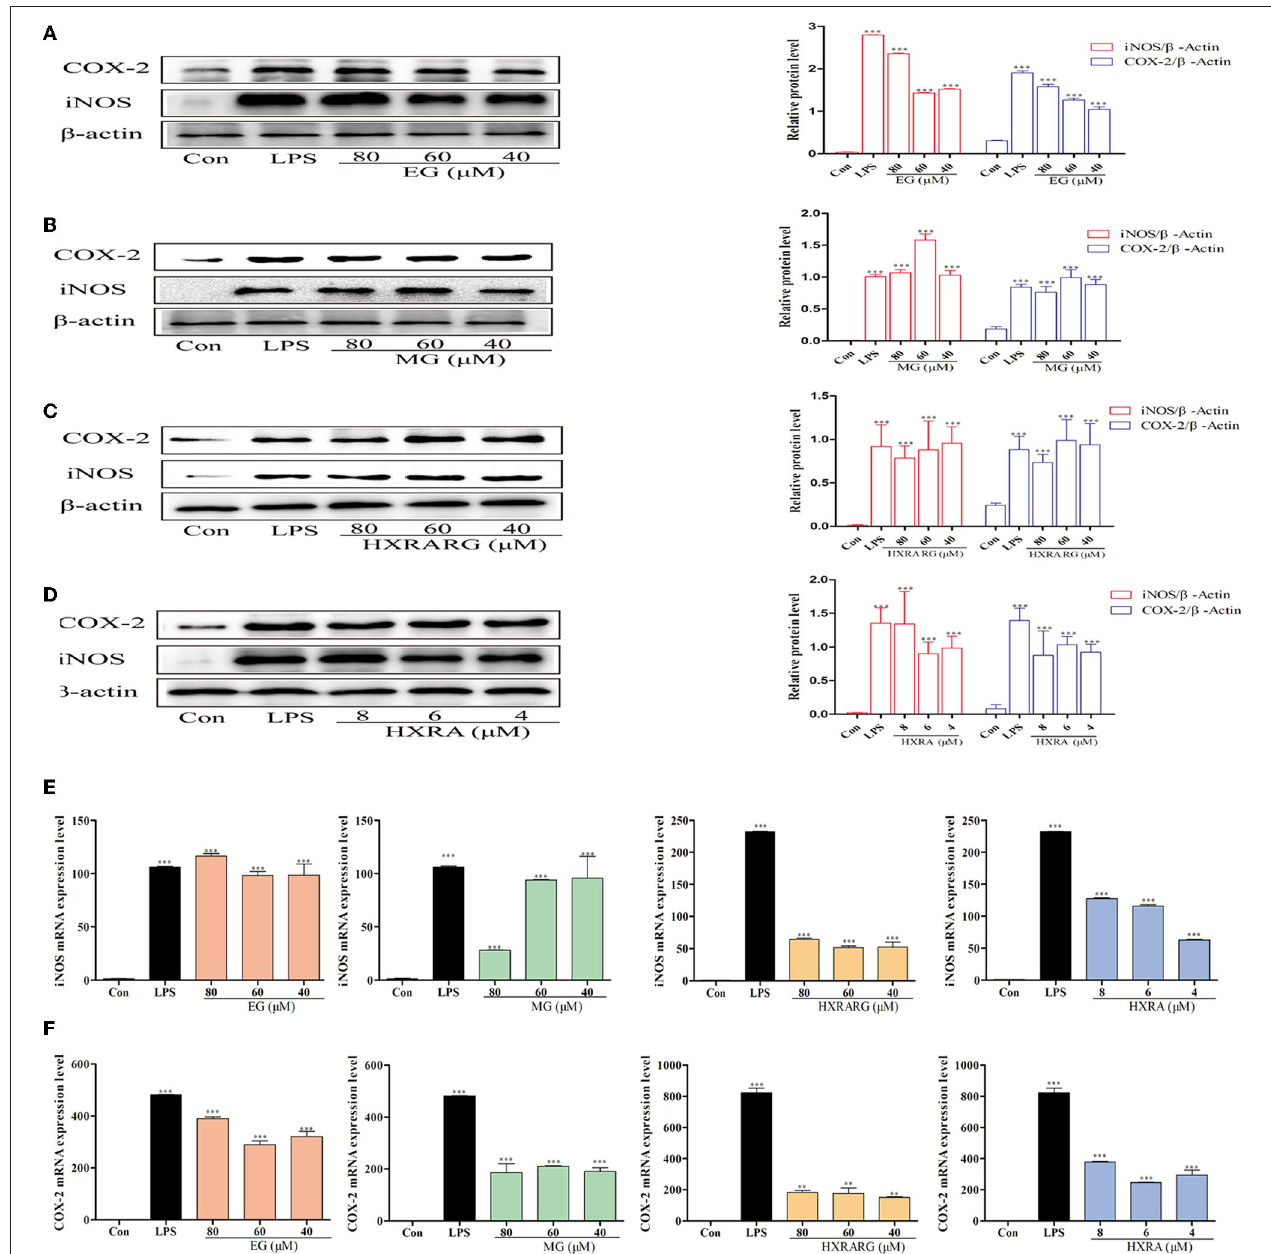
FIGURE 5 | Effects of different concentrations of EG, MG, HXRARG, and HXRA on iNOS and Cox-2 protein (A–D) and mRNA (E,F) expression in RAW264.7 cells. (A–D) : the left side was the protein band diagram, and the right side was the protein quantification diagram. (E) mRNA expression of iNOS. (F) mRNA expression of COX-2. Data are expressed as the means ± SD. Compared with the control, ** P < 0.01, *** P <